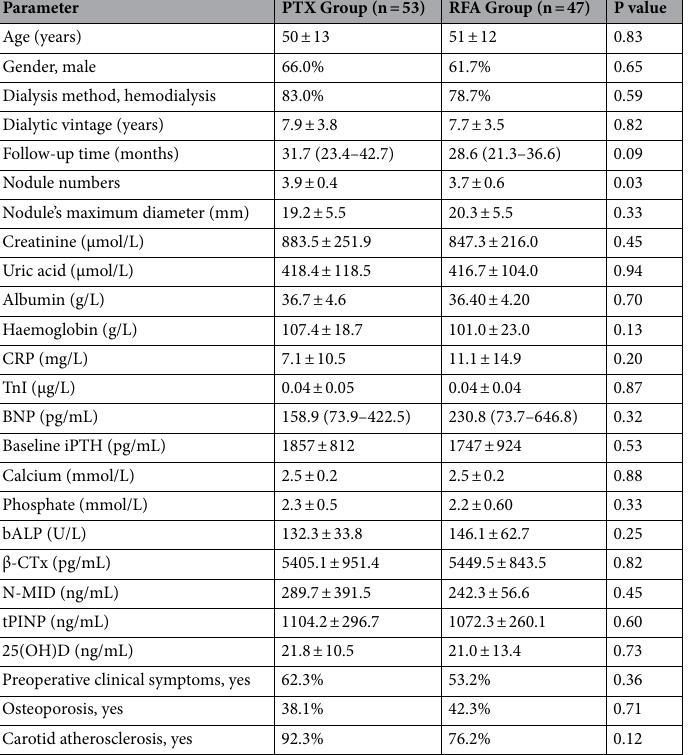
Table 1. Patients’ baseline characteristics. PTX parathyroidectomy, RFA radiofrequency ablation, CRP C-reactive protein, TnI Troponin I, BNP B-type natriuretic peptide, iPTH intact parathyroid hormone, bALP